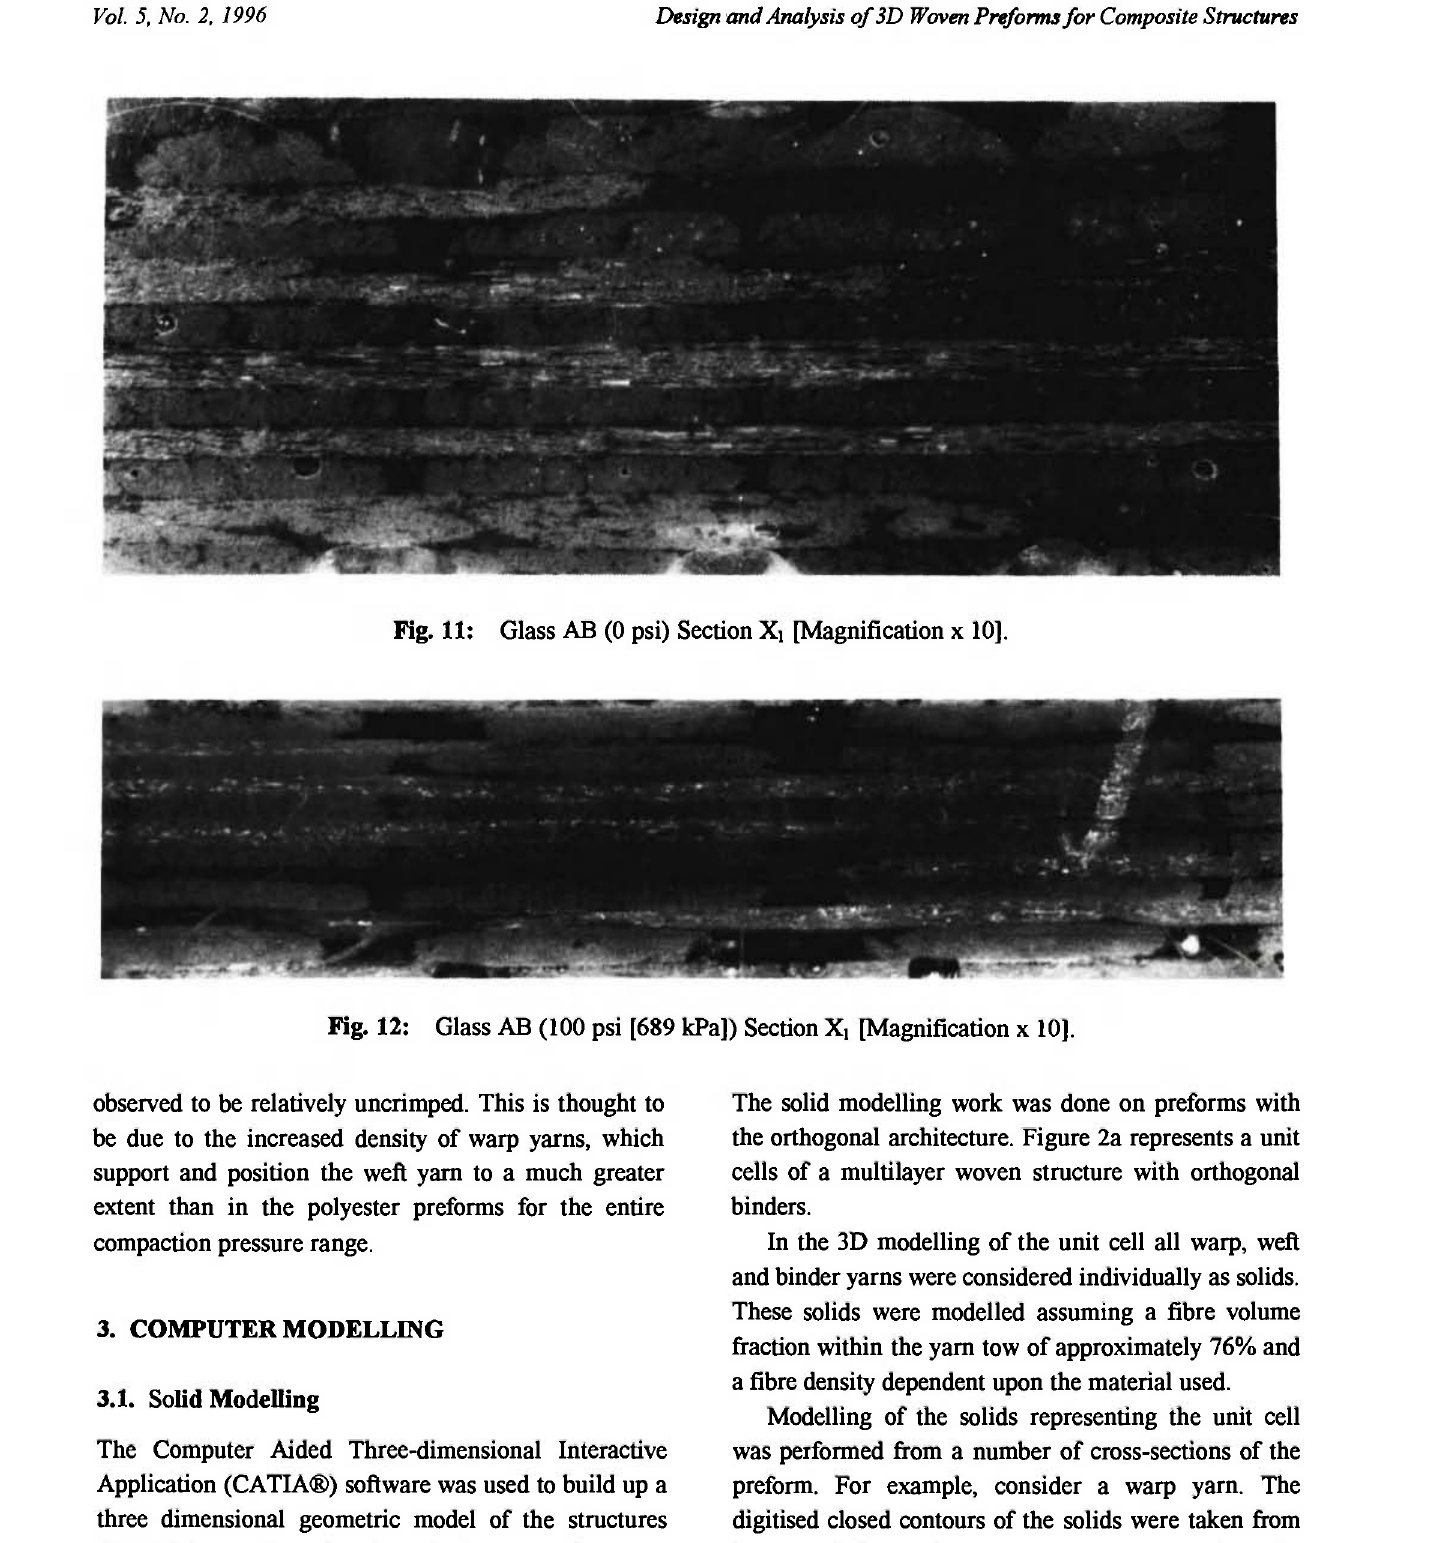
Fig. 12: Glass AB (100 psi [689 kPa]) Section X, [Magnification χ